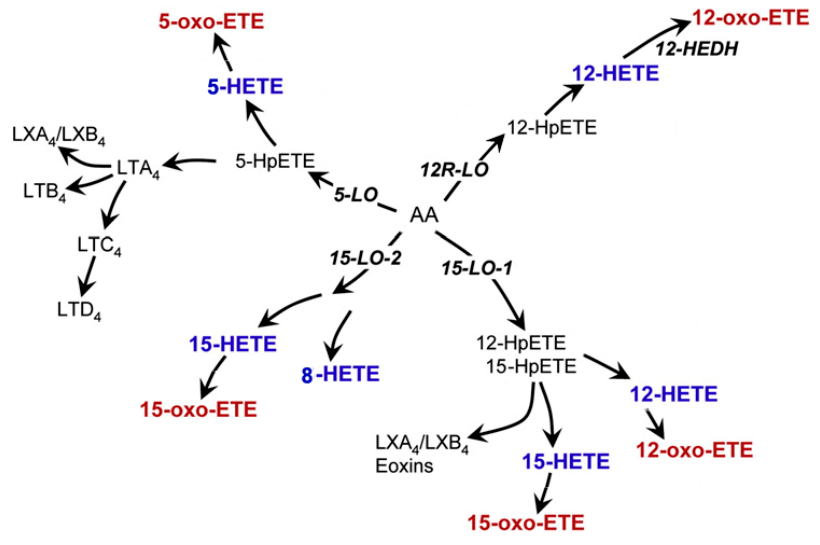
Figure 2. Lipoxygenase, and dehydrogenase pathways for the formation of HETEs, oxo-ETEs, and related eicosanoids.